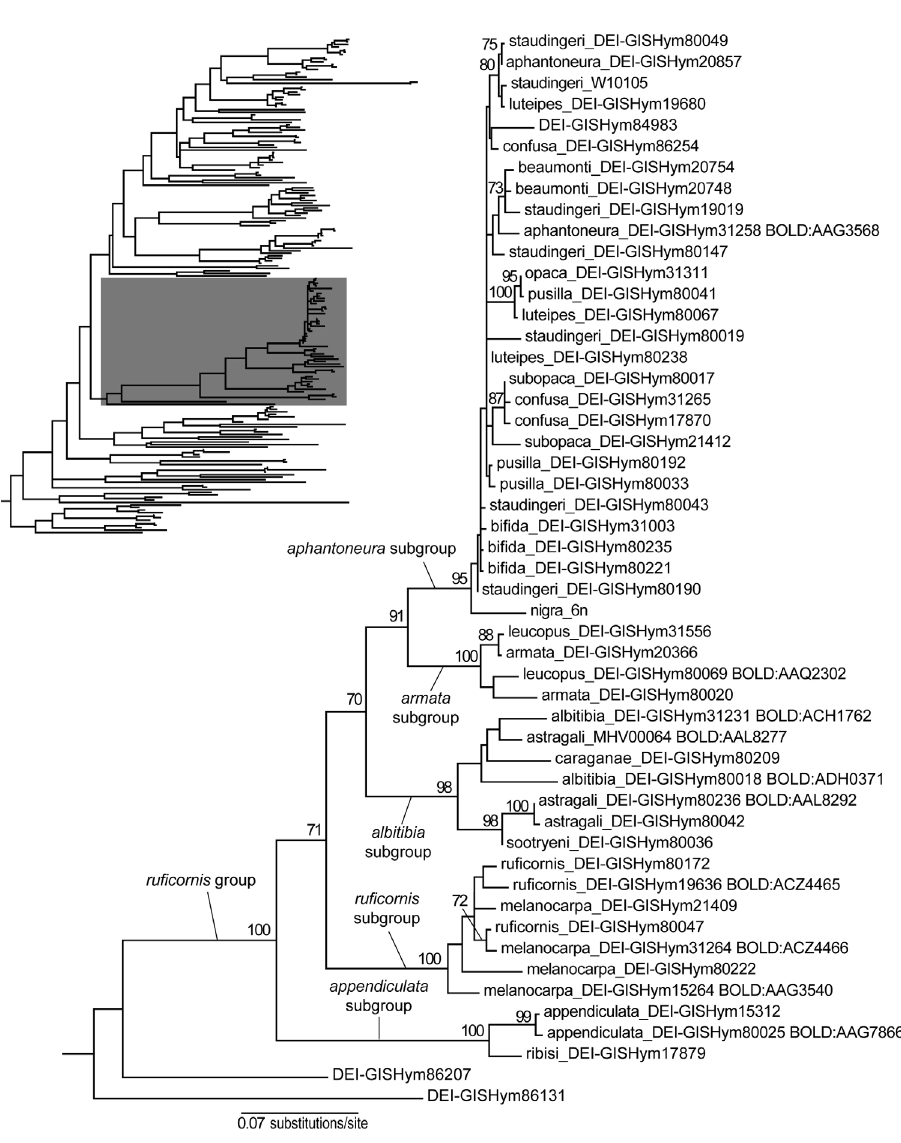
Figure 4. Part of the maximum likelihood tree shown in Fig. 3. Numbers above branches show bootstrap proportions (%). Support values for weakly supported branches (BP<70) are not shown. BIN numbers (BOLD:XXXXXXX) referred to in the text are shown for representative specimens. Outline of the full tree is shown upper left, with the part shown here highlighted. The scale bar shows the number of estimated substitutions per nucleotide